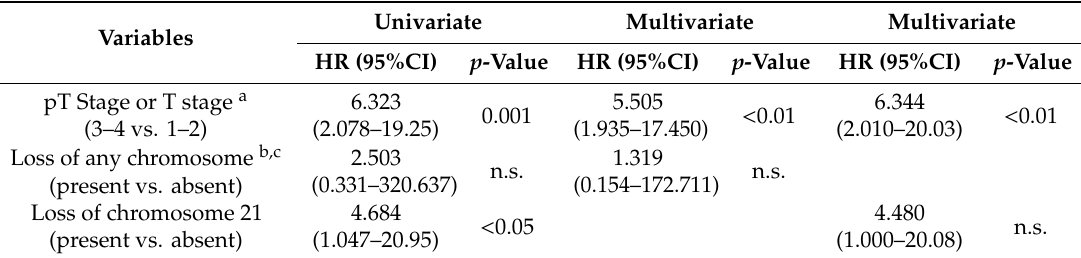
combined from Swiss and TCGA-KICH